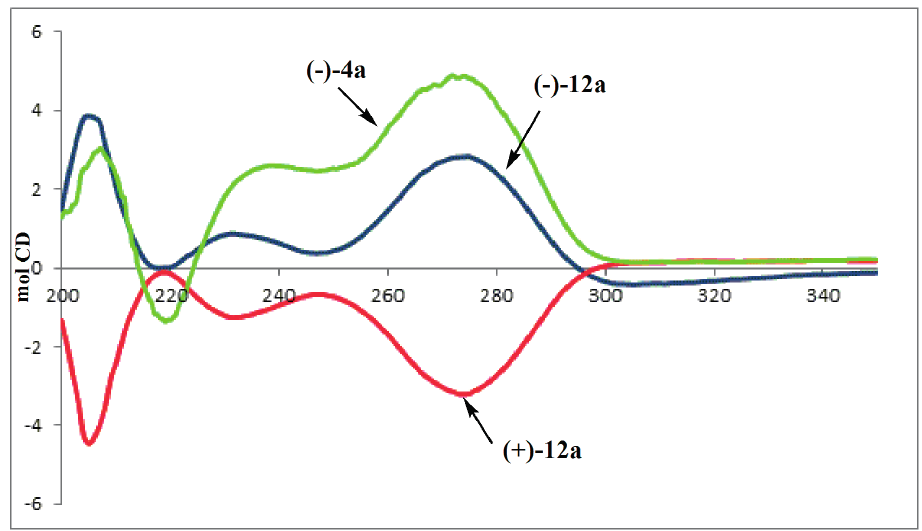
Figure 2. CD Spectra recorded in methanol of ( − ) 4a , ( − ) 12a and (+) 12b